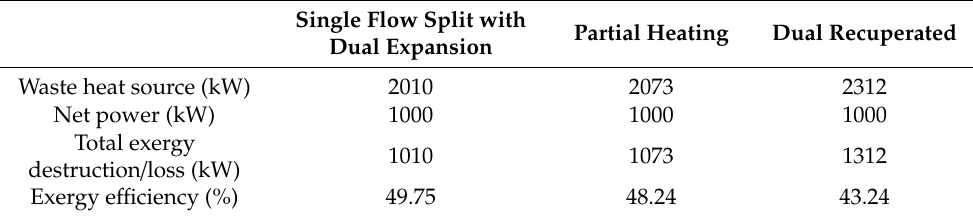
Table 9. Exergy of the waste heat source, net power output, and exergy e ffi ciency of the three advanced s-CO 2 power cycles for